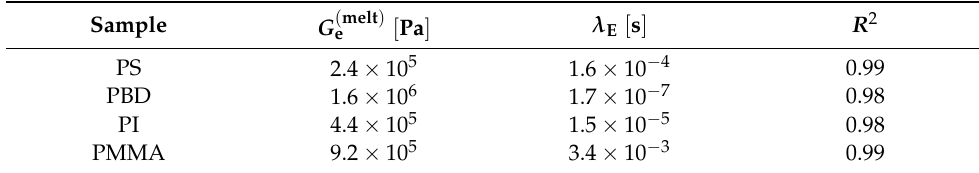
Table 2. Results of the regression analysis for four kinds of polymers.